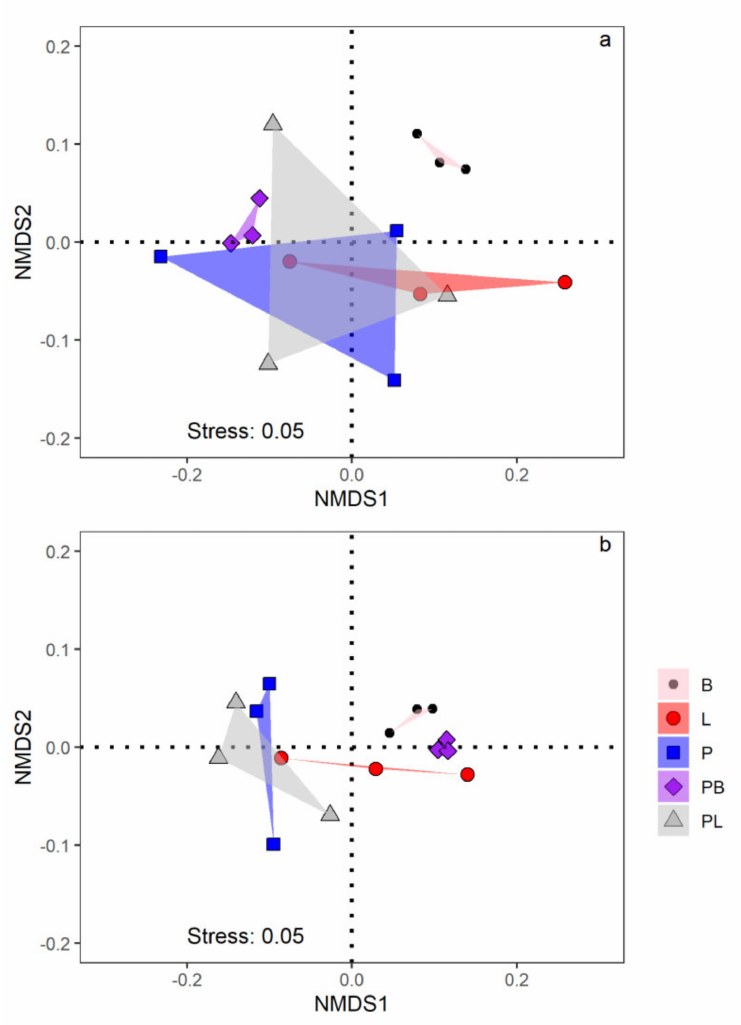
Figure 1. Non − metric multidimensional scaling (NMDS) based on the Bray − Curtis analysis of the community structure of fungi ( a ) and bacteria ( b ) in monoculture and mixed forests soil. Colors of symbols represent forest types. B, Betula platyphylla ; L, Larix gmelinii ; P, Pinus sibirica ; PB, P. sibirica and B. platyphylla ; PL, P. sibirica and L. gmelinii